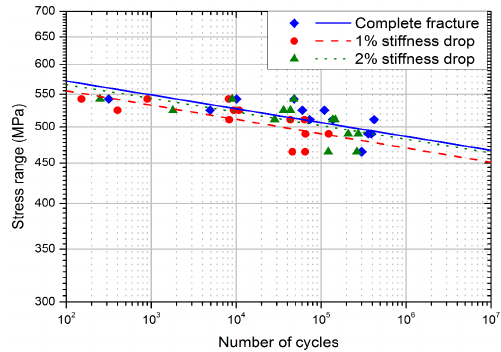
Figure 16. CFRP stiffness drop S–N curves.